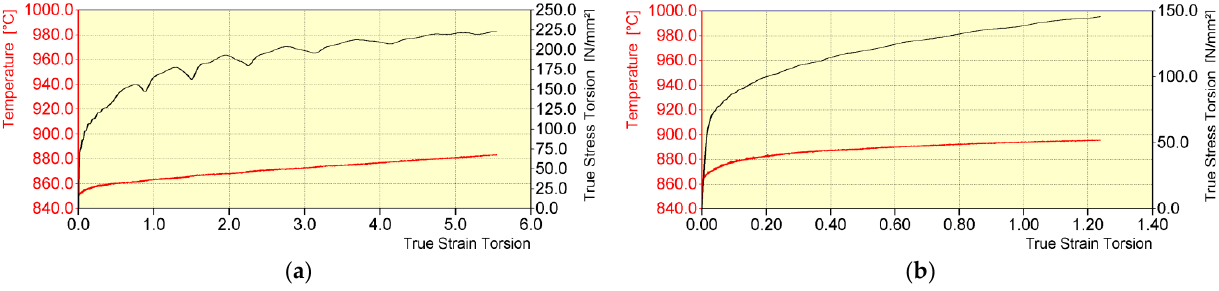
Figure 10. General course of temperature (nominal and obtained) and yield stress during physical modelling of rolling a 20MnB4 steel wire rod with a diameter of 5.5 mm (test variant V2): ( a ) in an NTM block and ( b ) in an RSM block. Table 4. Parameters of the deformation process during physical modelling of rolling a 20MnB4 steel wire rod with a diameter of 5.5 mm in NTM and RSM blocks of a wire rod rolling mill (test variant V2) [17,21].